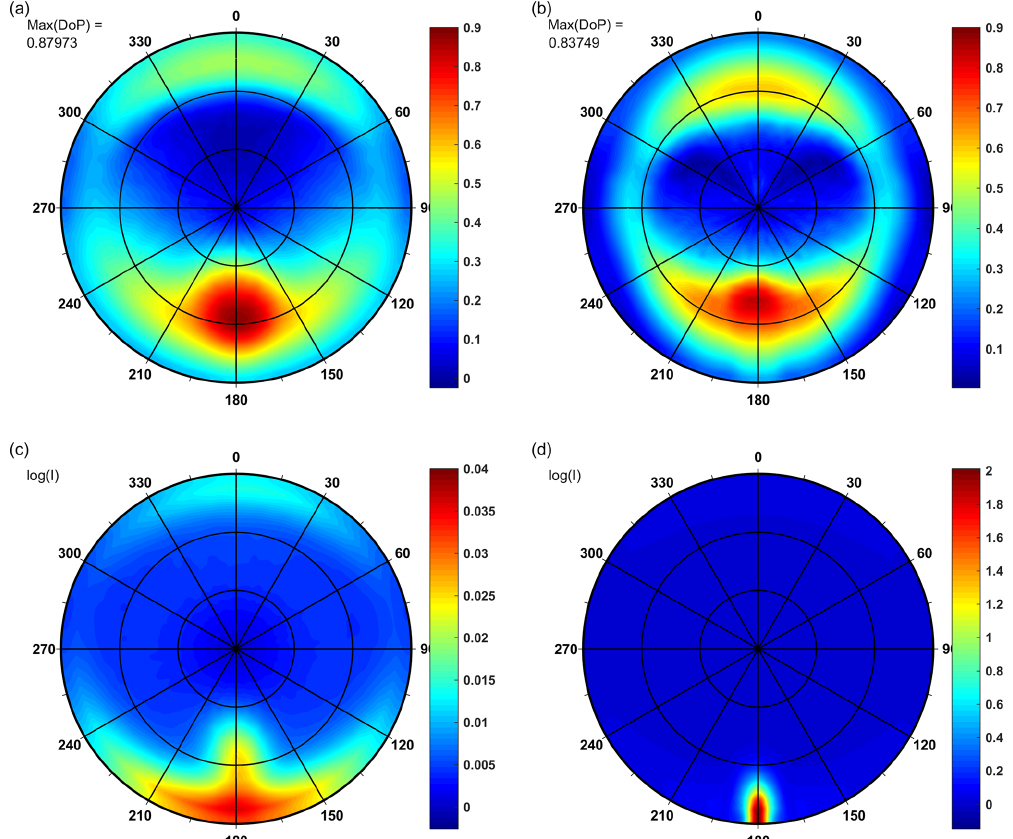
Figure 2. Simulation results of above-water upwelling radiance for average IOPs of open waters of the southern Baltic, wavelength 412nm, for wind speed of 5ms − 1 : (a) DoP in the summer season, SZA 45 ◦ , (b) DoP in the winter season, SZA 75 ◦ , (c) decimal logarithm of upwelling radiance in the summer season, SZA 45 ◦ , (d) decimal logarithm of upwelling radiance in the winter season, SZA 75 ◦ . Concentric circles inside mean zenith angles of 30 and 60 ◦ , respectively.